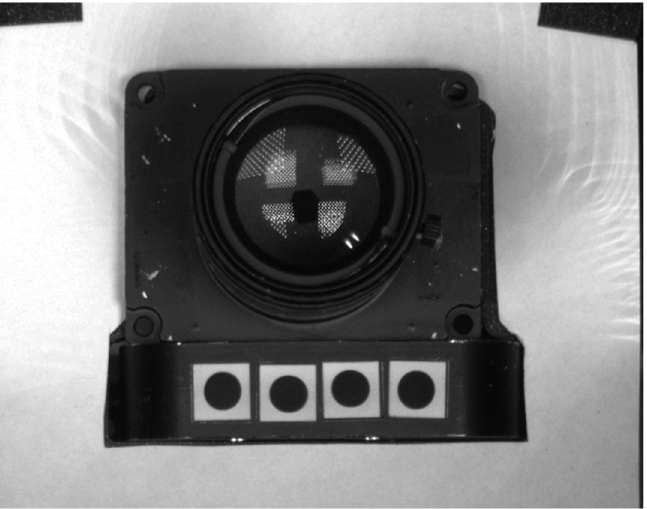
Figure 5. Scene of the tested camera and the markers on the surface of the invar camera stage observed from the observing camera, which is positioned outside the thermal chamber.